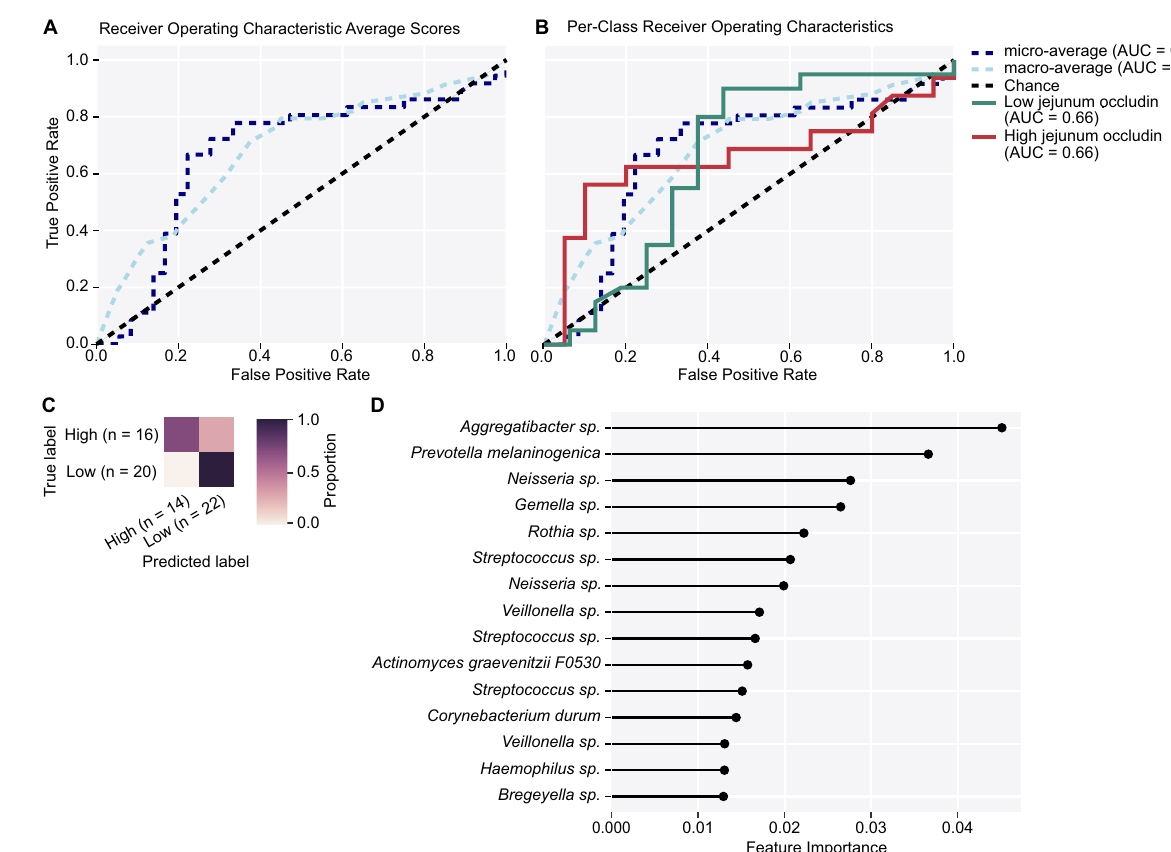
Figure 7. Machine learning classification accuracy in a nested cross-validation random forest model built to predict jejunum occludin concentrations (in pg/ml) based on features of the cecal microbiome in mice from this study. Feature inputs from the raw feature table included in this analysis consisted of all bacteria matched to the Silva_132 ribosomal RNA gene reference database with 99% accuracy. (A) Receiver operating characteristic (ROC) plot shows macro-average precision (each jejunum occludin classification equally-weighted, light blue dashed line, AUC = 0.68) at several true-positive rate (TPR) against false-positive rate (FPR) thresholds; micro- average precision (averaged metrics across each sample, dark blue dashed line, AUC = 0.67) at several TPR against FPR thresholds; and classification error rate achieved by random chance (black dashed line). (B) Per- class ROC shows the prediction results for low (forest green, AUC = 0.66) and high (red, AUC = 0.66) jejunum occludin classifications in study mice. The overall accuracy in classifying low and high jejunum occludin in study mice was 66%. (C) The prediction matrix shows that all but 2 samples were correctly classified by the machine learning algorithm. More accurate assessments of the true group designation by the algorithm are correlated with darker shading. (D) Top 15 feature rankings in the random forest analysis. AUC area-under-the- curve, FPR false positive rate, ROC receiver operating characteristics, TPR true positive